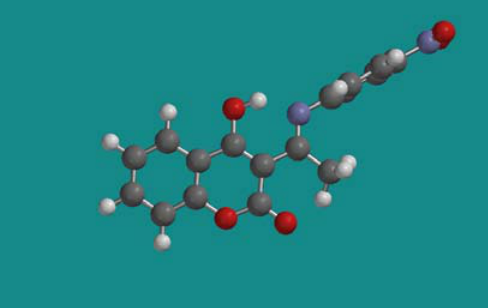
Figure 4. Spartan geometry of 4-hydroxy-3-(1-(4-nitrophenylimino)ethyl)-2H-chromen-2- one ( 13b ).